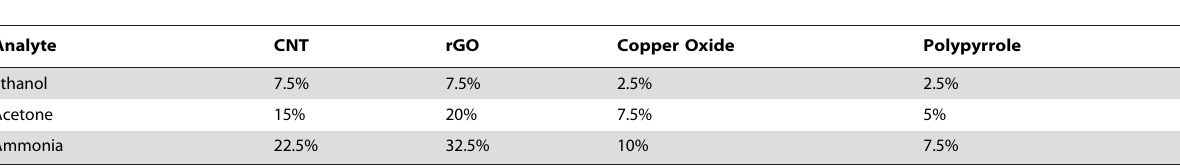
Table 2. Average response magnitudes of sensor element material to different analytes.